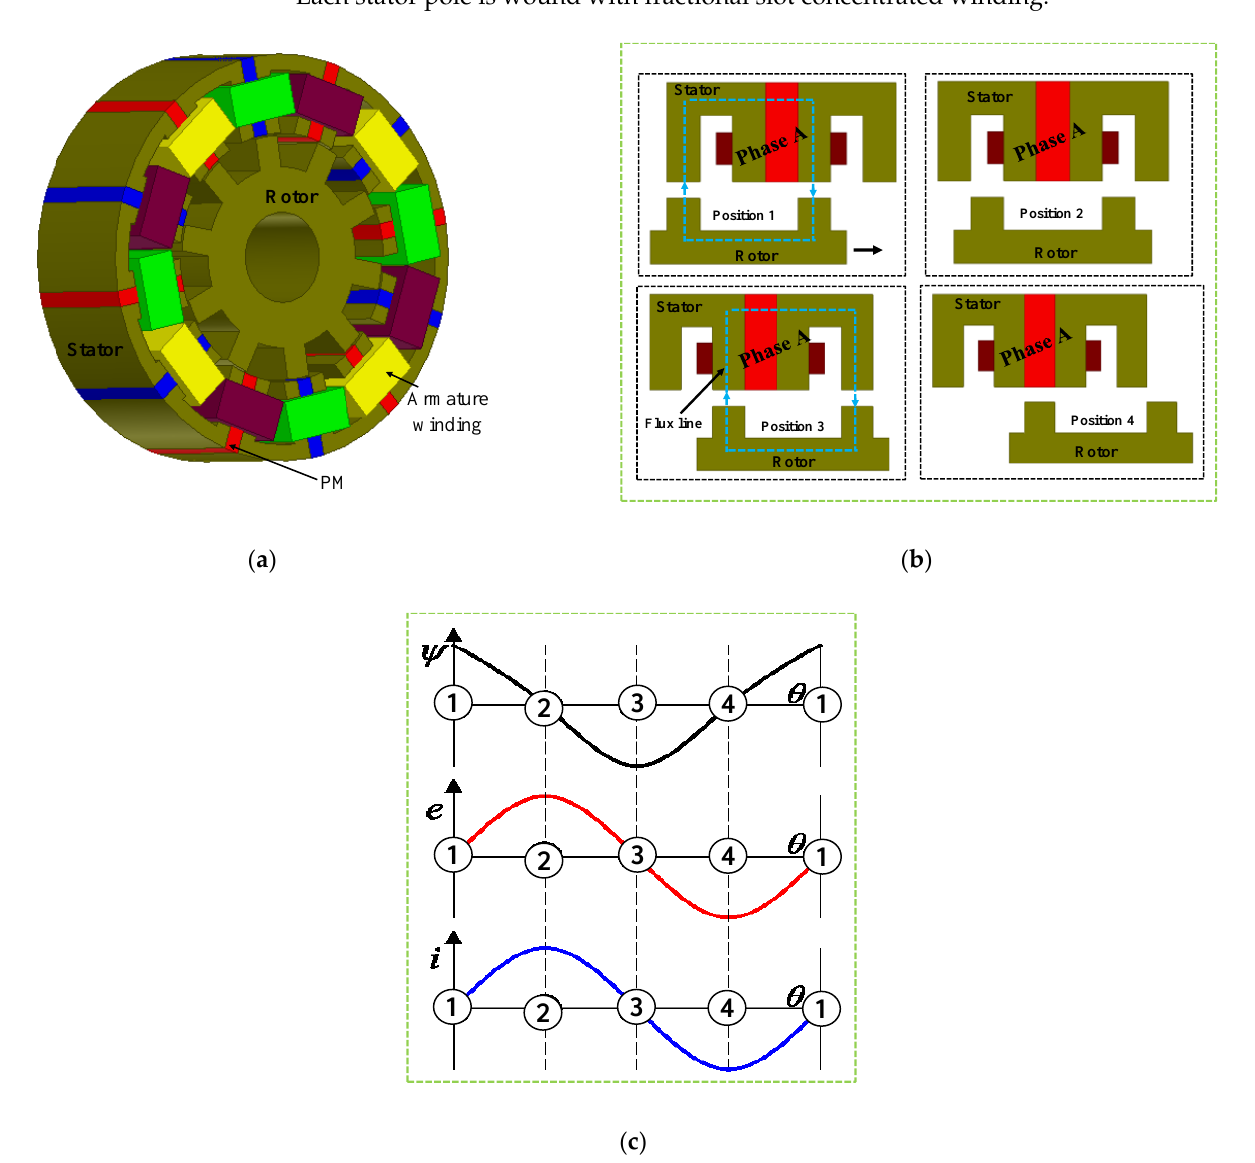
Figure 9. 12/10-pole, 3-phase FSPMM: ( a ) motor topology; ( b ) rotor at four different positions; ( c ) idealized waveforms of flux-linkage, back-EMF, and phase current for the rotor positions. Operating